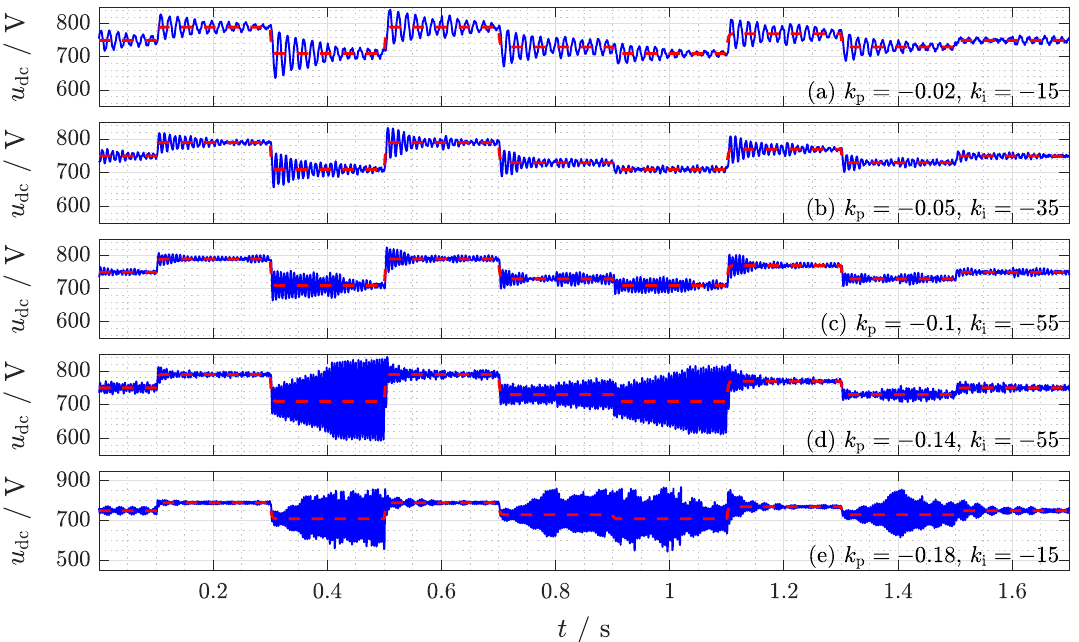
Figure 8. Experiment (E1)—Measurement results: Time sequences of dc-link voltage control loops with different parameter sets of k p and k i , i.e. ( a ) k p = k i = 35 A ; ( c ) k p = Vs − k i = 15 A ; close to the stability boundary (see points ( a – e ) in Figure 7b). [Color code: reference Vs −